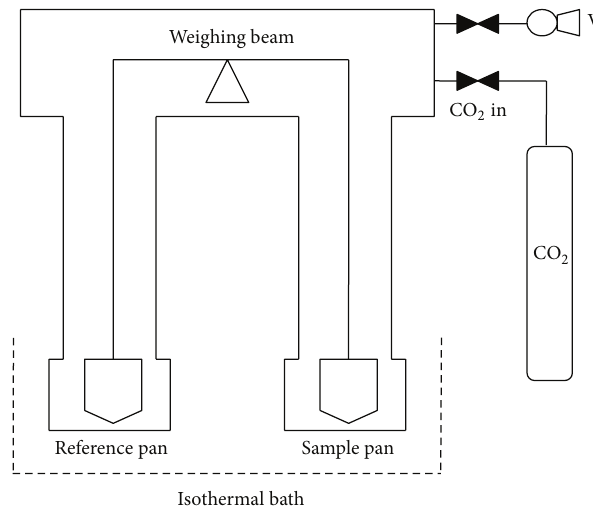
Figure 3: Basic components of a gravimetric